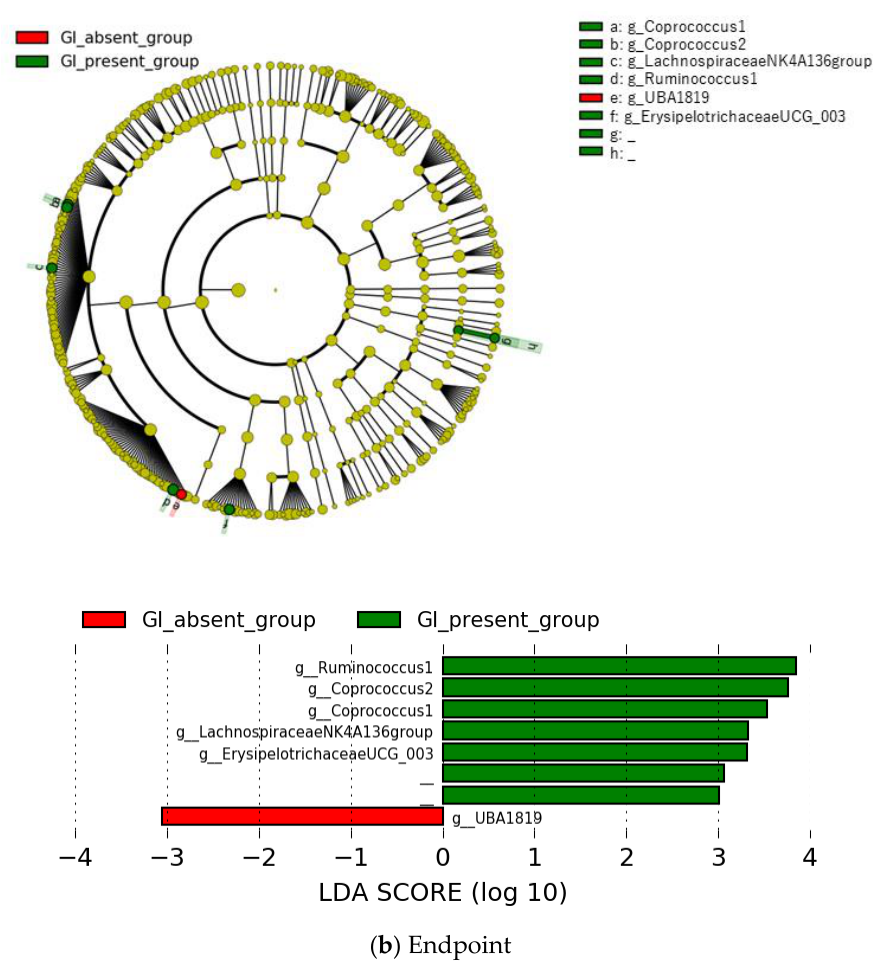
Figure 5. Specific bacterial contributor to GI-present symptom ( n = 8, green) and GI-absent symptom ( n = 6, red) groups by the LEfSe analysis (LDA >3.0) at genus level in the late-life group; Baseline ( a ), Endpoint ( b ). Notes: “f” = family level, “g” = genus level, “c” = class level, and “o” = order level.